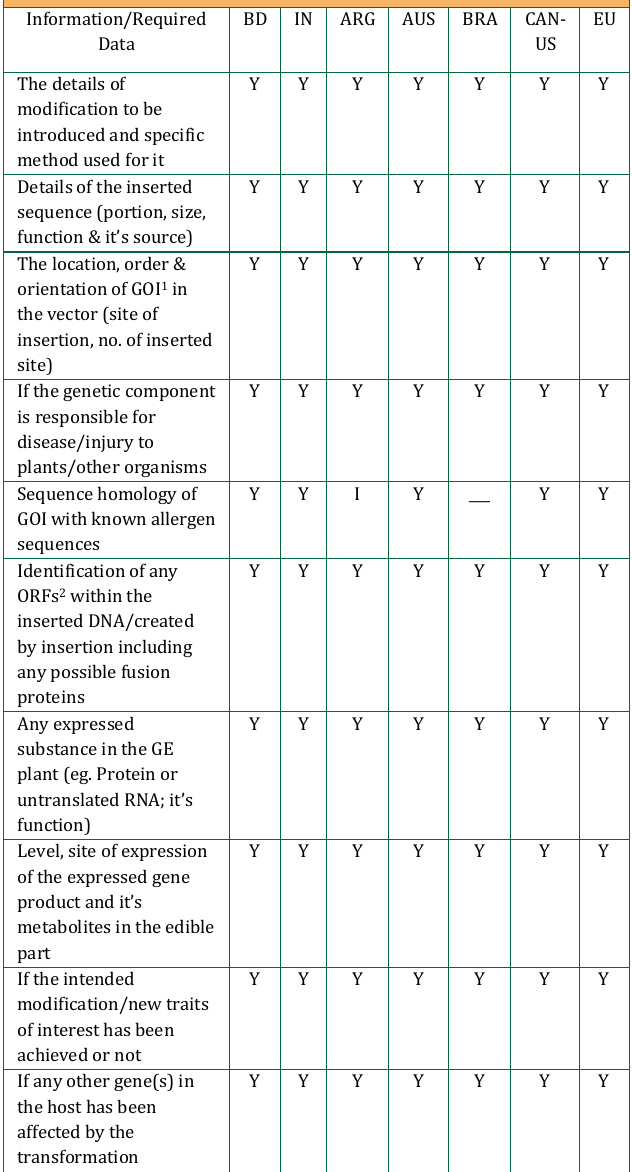
Table 3: Data requirement on the description of genetic modification